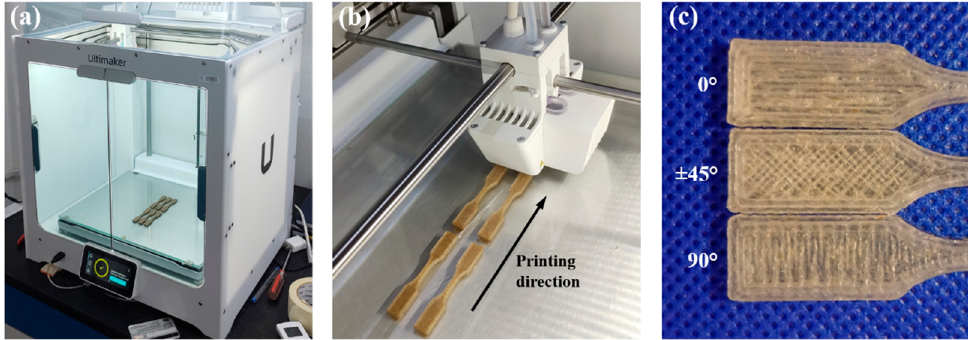
Figure 3. ( a ) 3D printer; ( b ) 3D printed NFRC tensile samples with a raster angle of 0°; ( c ) 3D printed NFRC tensile samples with raster angles of 0°, ±45° and 90° and with a fiber flour content of